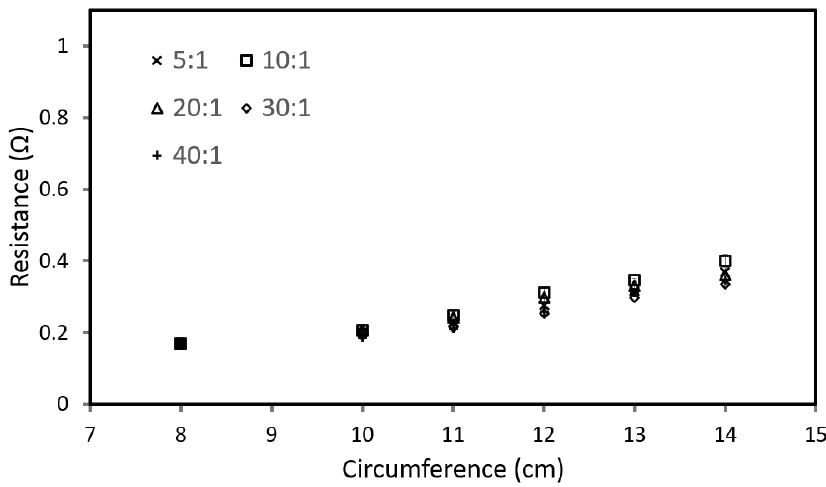
Figure 7. Comparison of resistance value for T-sensors with different mixing ratios.